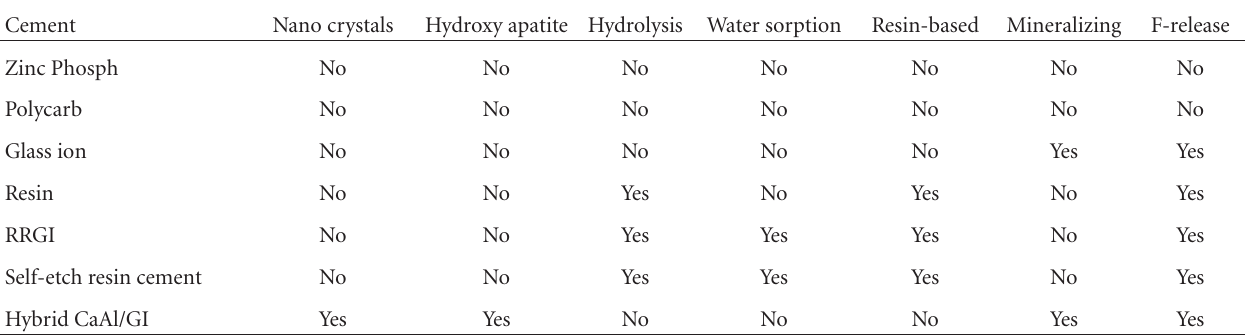
Table 2: Comparison of additional properties of the various generic